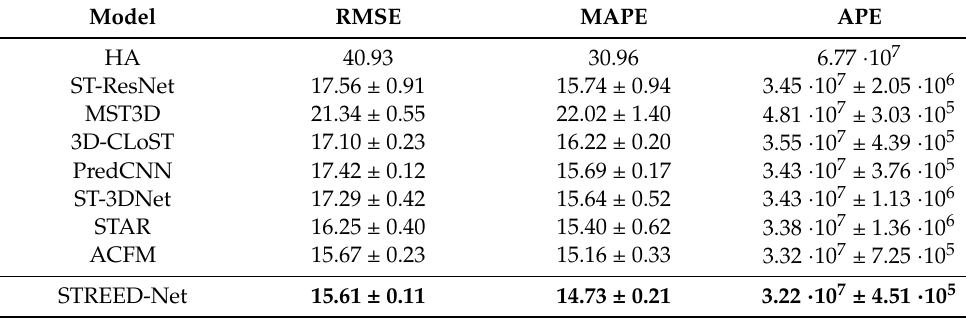
Table 2. Results obtained for the Taxi Beijing data